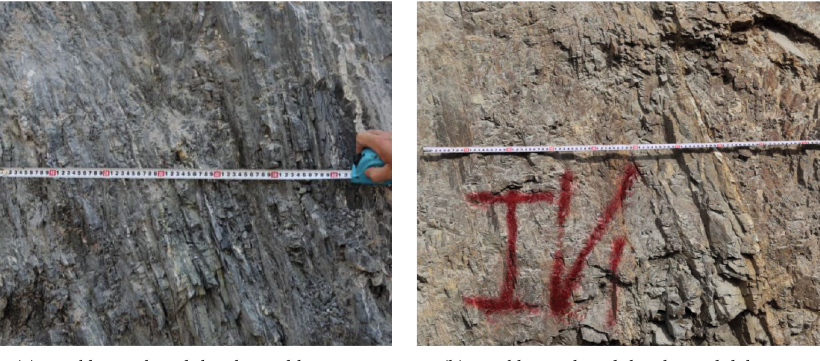
Figure 4: Typical rock mass of slope.